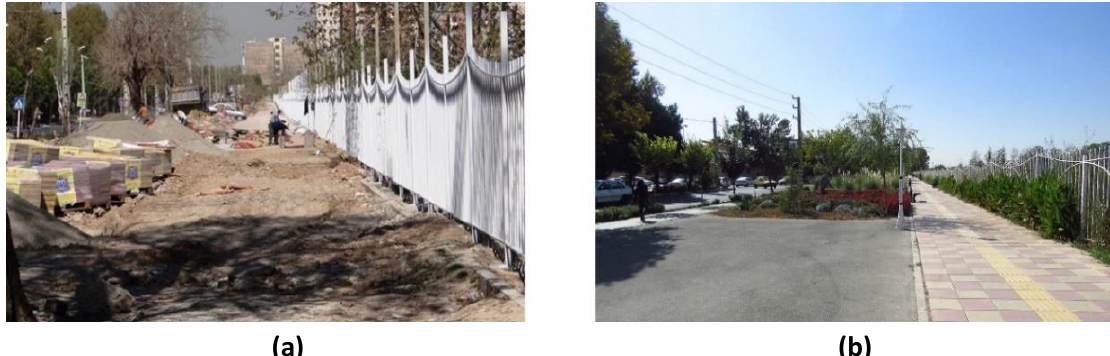
Fig. 2: Danesh Pedestrian and Bicycle Path: (a) during construction, 2014; (b) after construction, 2016